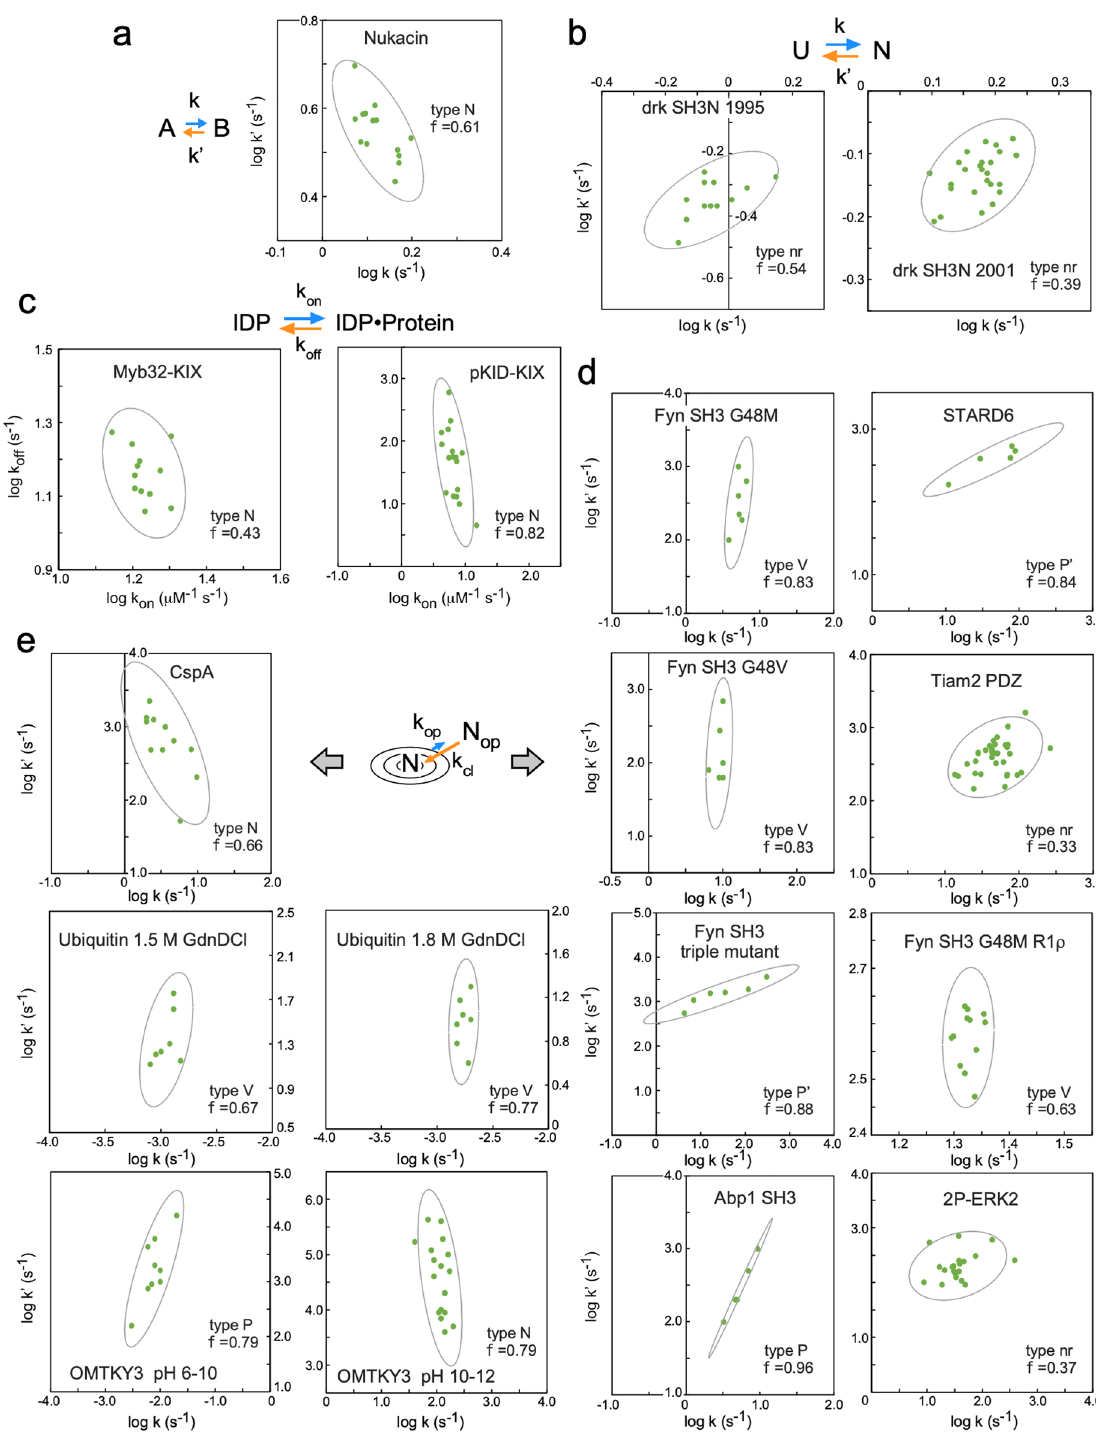
Figure 3. Datapoint distributions in the log k vs. log k ′ plots. In each panel, the category type defined in Fig. 2, a 95% confidence ellipse, and the flatness of distribution are shown. The flatness of the distribution is defined by f = 1-b/a, where a is the long axis and b is the short axis of the confidence ellipse. The axis ranges are set equally for the proper interpretation of the flatness of the confidence